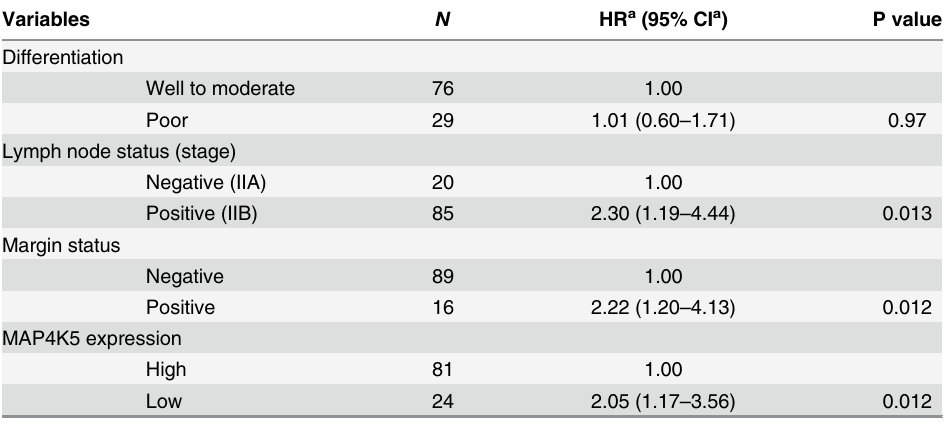
Table 3. Multivariate analysis of overall survival in patients with stage II pancreatic ductal adenocarcinoma. Variables N HR a (95% CI a ) P value Differentiation Well to moderate 76 1.00 Poor 1.01 (0.60 – 1.71) Lymph node status (stage) Negative (IIA) 1.00 Positive (IIB) Margin status Negative 89 Positive MAP4K5 expression High